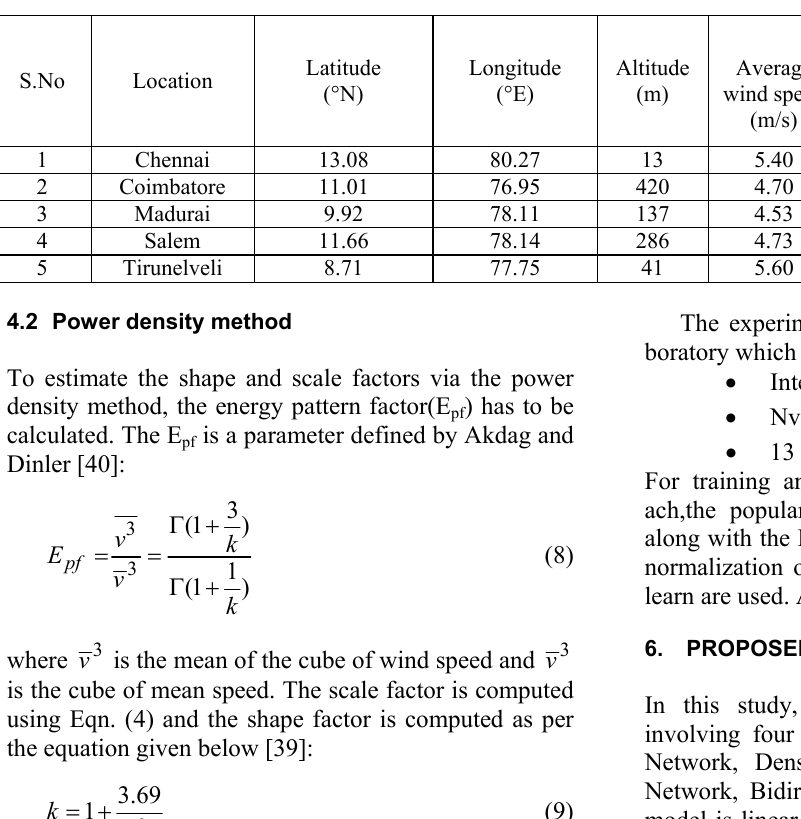
Table 1. Topographical details of the chosen stations